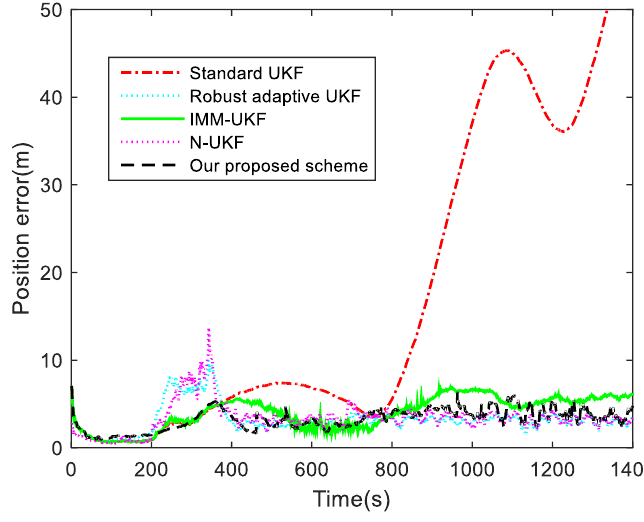
Figure 7. Position tracking errors for Case 3. Table 3. Position errors of the different schemes for Case 3.